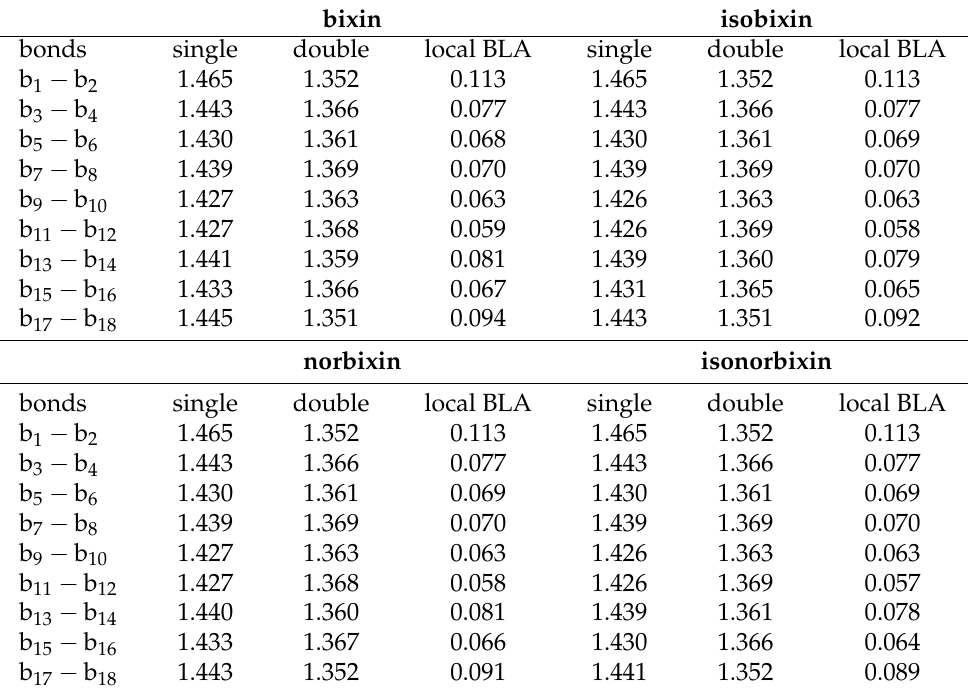
Table A6. Single-double bonds and local BLA values (Å) of the molecular dyes in chloroform solution. These results were obtained by employing the M06/6-31+G(d,p) level of theory.